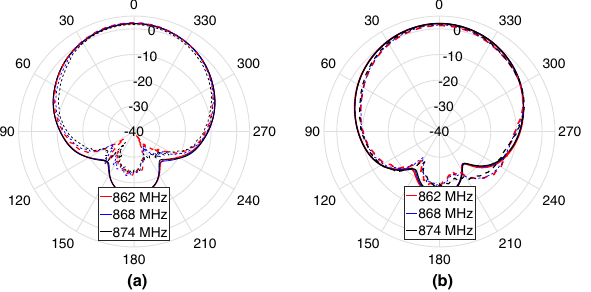
Figure 12. Measured (dashed-line) and simulated (solid-line) radiation patterns of the proposed MPA in the ( a ) x – z and ( b ) y – z planes.